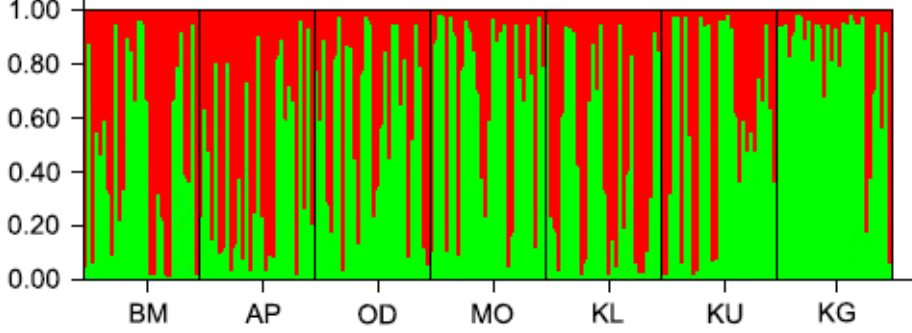
Figure 3. Results from structure analysis of pedunculate oak populations when K = 2. Table 6. Corrected genetic differentiation (F ST ) between populations, using the INA method (above the diagonal) and the ENA method (below the diagonal), * p < 0.05 Relationships among the populations were estimated with Cavalli–Sforza and Ed- ward’s chord genetic distances (DC) [52] using the INA method computed in FreeNA (DC INA ) (Table 6); the greatest distance occurred between the KL and BM (F ST ENA = 0.028, DC INA = −0.349), and the smallest distance was between KG and KU (F STENA = −0.0002), and for MO and KL (DC INA = 0.294).